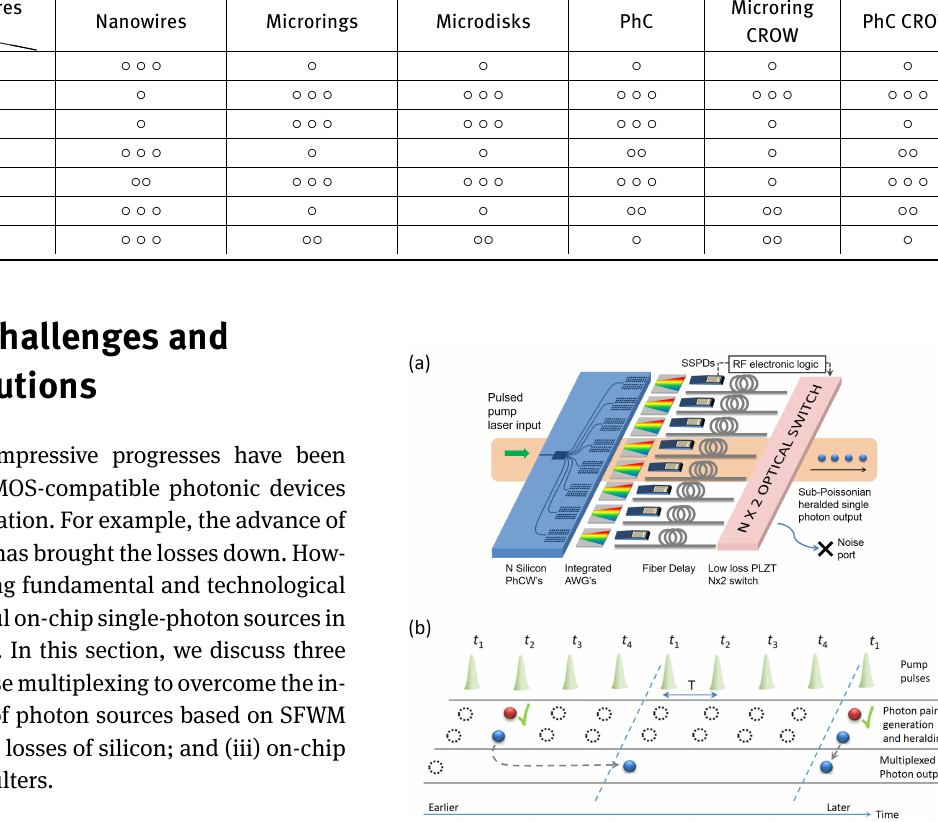
Table 2. Summary of different silicon structures. More circles represent more favourable features. (cid:96)(cid:96)(cid:96)(cid:96)(cid:96)(cid:96)(cid:96)(cid:96)(cid:96)(cid:96)(cid:96)(cid:96) Structures Performance